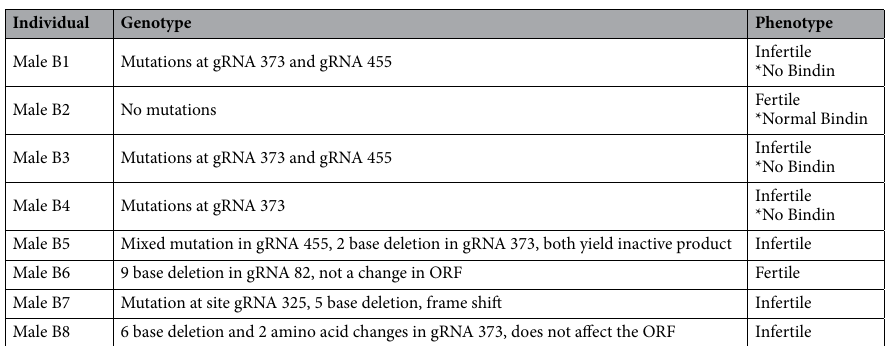
Table 1. Tabulation of mutations and phenotypes.